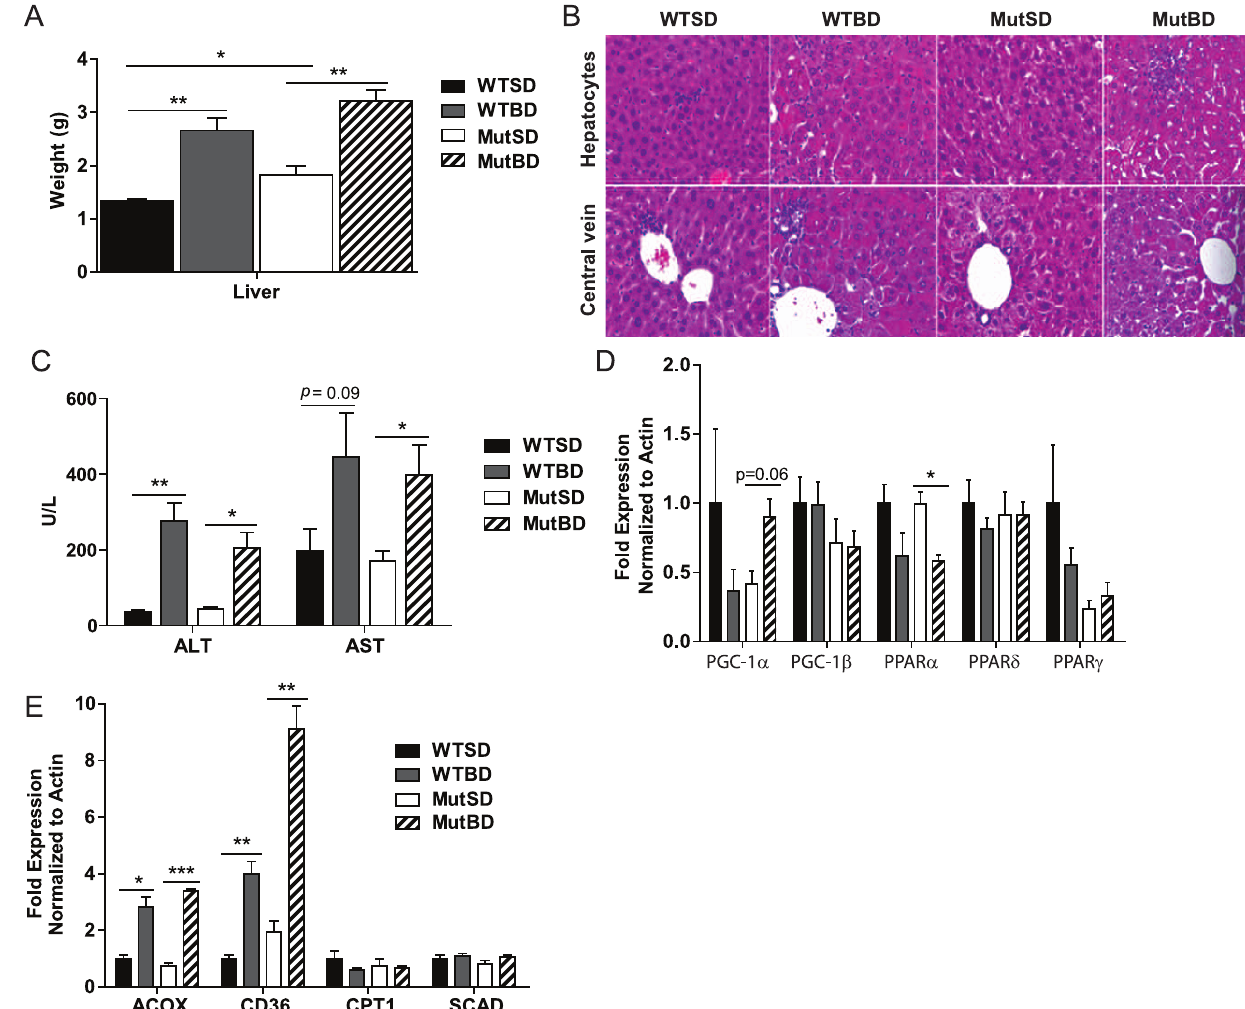
Figure 5. Bezafibrate induces hepatomegaly and fatty acid oxidation in Mut and WT mice. (A) Liver weight of 10 month-old mice (n=4– 6/group). (B) H&E staining of the liver of 10 month-old mice showing hepatocytes and central vein (n=4/group). (C) The level of liver enzymes alanine aminotransferase (ALT) and aspartate aminotransferase (AST) in the blood of 10 month-old mice (n=6/group). (D) Gene expression of PGC-1 coactivators and PPARs in the liver of 10 month-old mice normalized to actin (n=4/group). (E) The mRNA level of markers of fatty acid oxidation in the liver of 10 month-old mice normalized to actin (n=4/group). Acyl-coenzymeA oxidase 1 ( ACOX ), cluster of differentiation 36 ( CD36 ), carnitine palmitoyl transferase ( CPT1 ) and short-chain-acyl-coenzymeA dehydrogenase ( SCAD ). *, P , 0.05; **, P , 0.01, *** P , 0.001, Student’s t -test. Error bars represent the SEM.